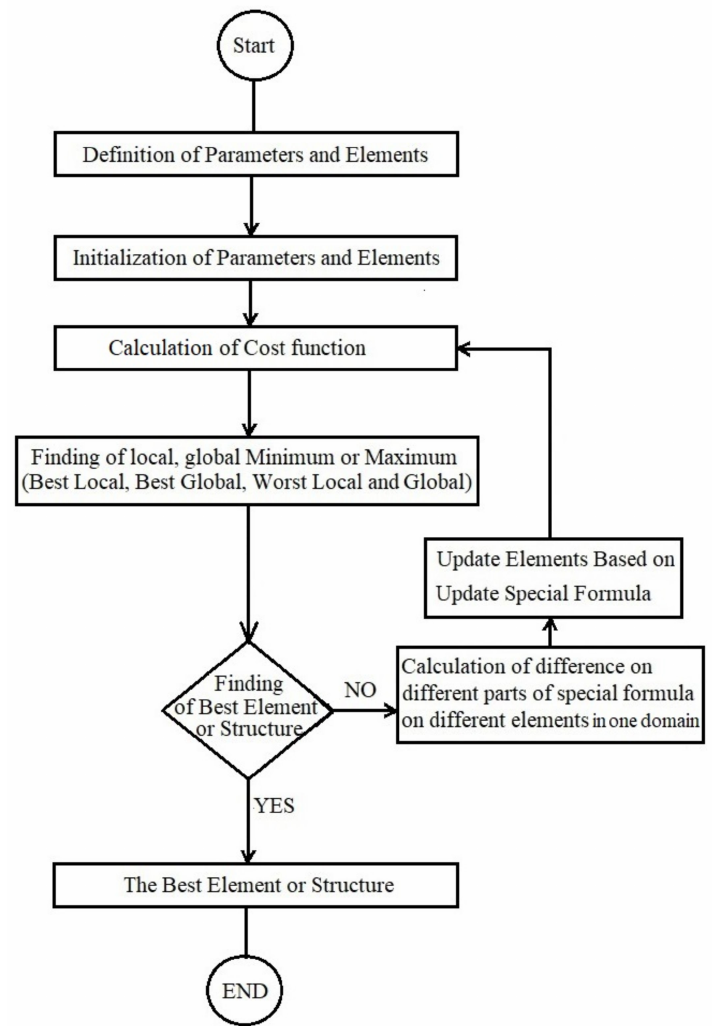
Figure 2. Overview of the Bond Graph